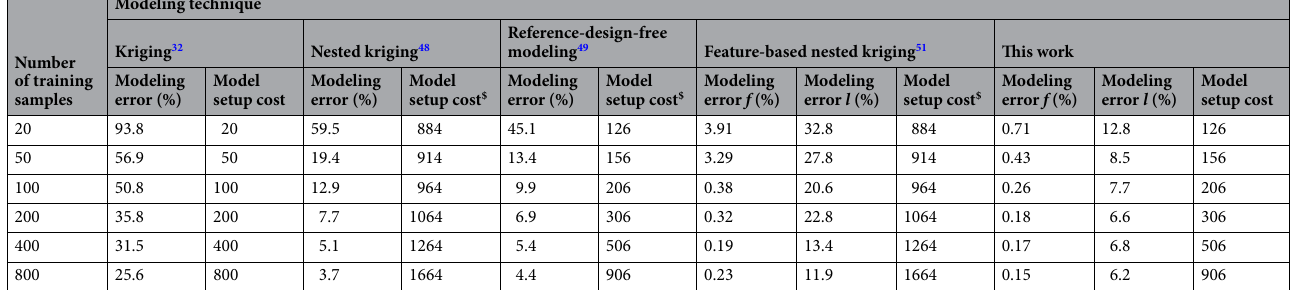
Table 4. Ring-slot antenna of Fig. 4a: modeling results and benchmarking. $ The cost includes acquisition of the reference designs, which is 864 EM simulations of the antenna when using feature-based optimization 50 as listed in the table. # The cost includes generation of random observables, here, 106 simulations in total to yield N r = 50 accepted samples.